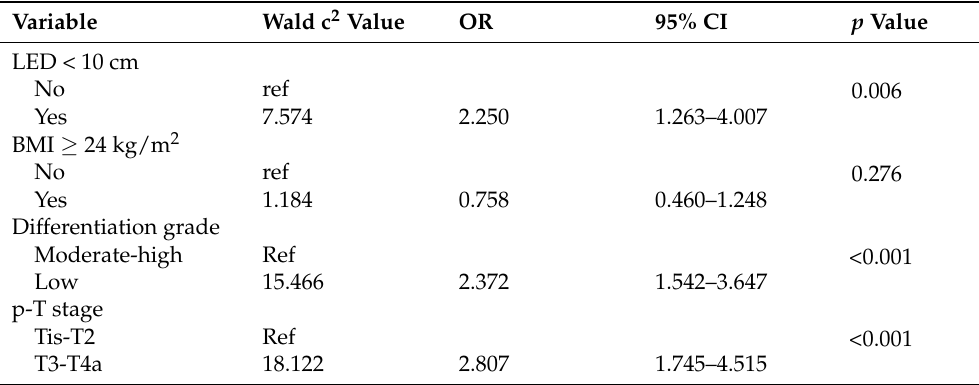
Table 2. Multivariate logistic regression analysis of abdominal LNM in middle ESCC.